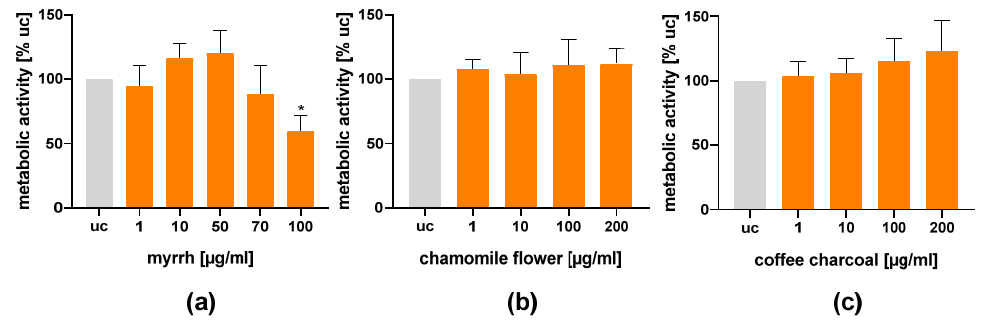
Figure 1. Effects of the plant extracts on the metabolic activity of RBL-2H3 cells. Cells were incubated overnight (18 h) with ( a ) myrrh resin extract (1–100 µg/mL); ( b ) chamomile flower extract (1–200 µg/mL); ( c ) coffee charcoal extract (1–200 µg/mL) and incubated for 2 h with XTT-assay solution. Results are presented as means ± SEM; n = 4 (myrrh); n = 6; * p < 0.05.